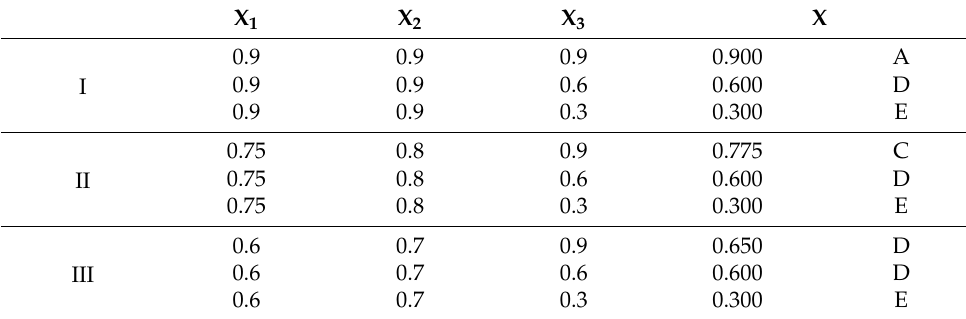
Table 2. The possible categories, based on the test results.